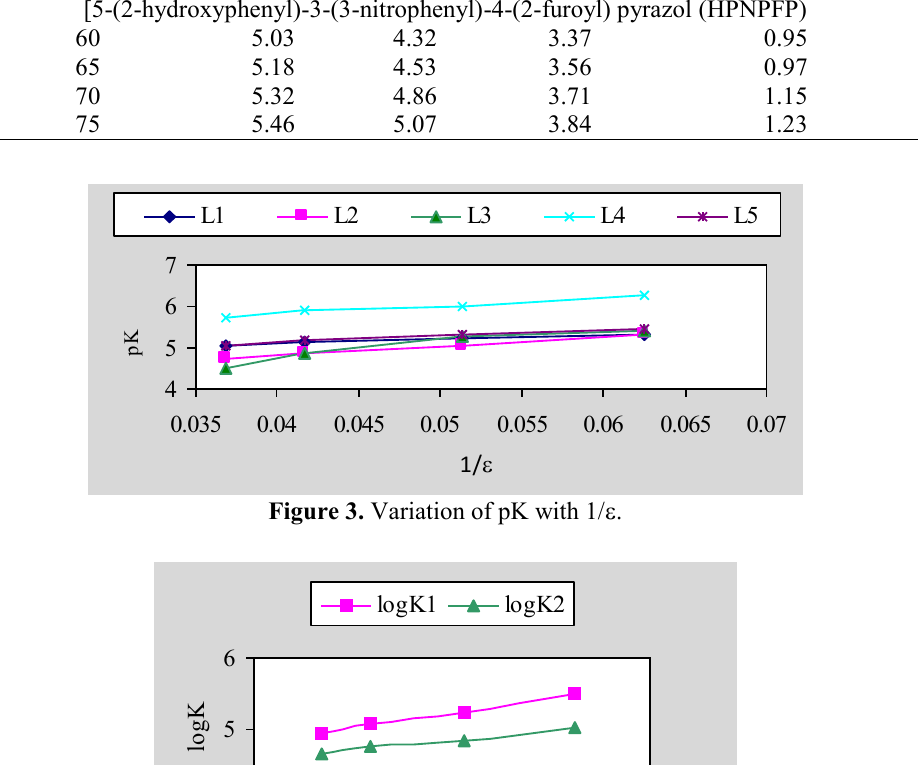
Figure 4-5. Variation of logK